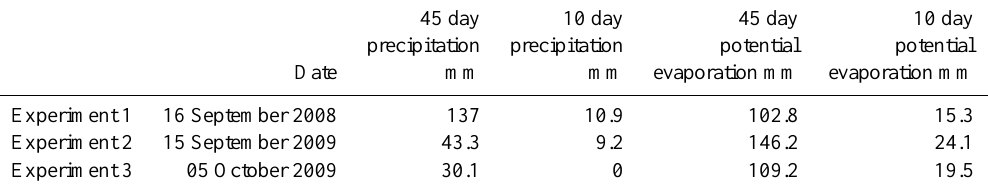
Table 2. Pre-experimental